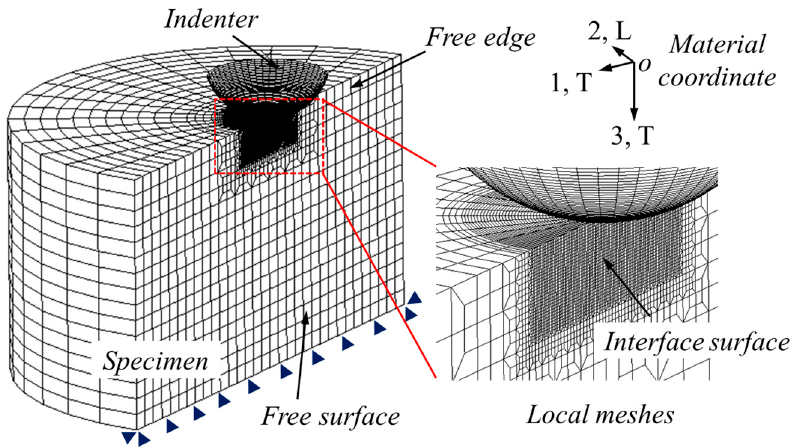
Figure 4. FE model, meshes, and boundary conditions used in the cross-sectional indentation simulation.